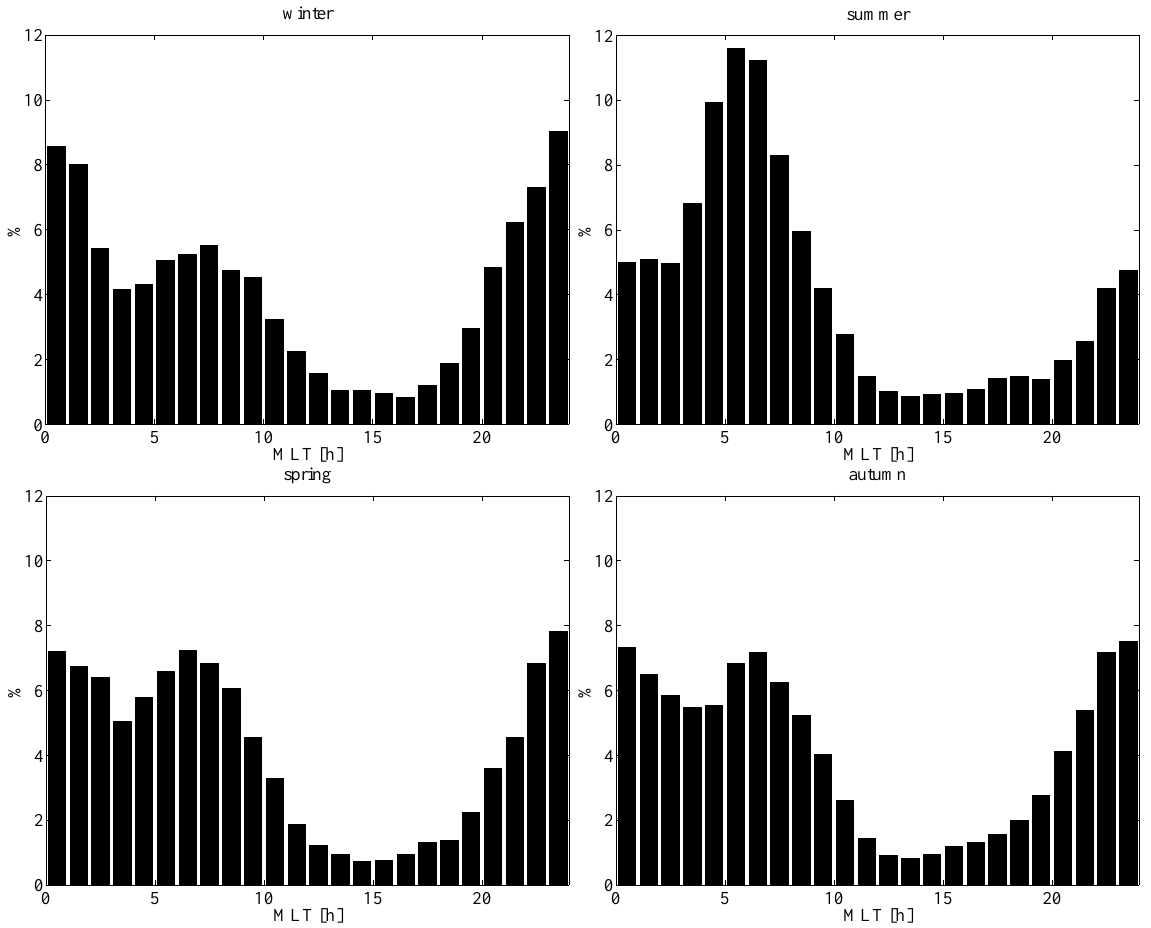
Fig. 4. Average diurnal occurrence of d H /dt exceeding 1nTs − at five stations in northern Europe (Table 1) over the solar cycles 22–23 in 1986–2009 during different